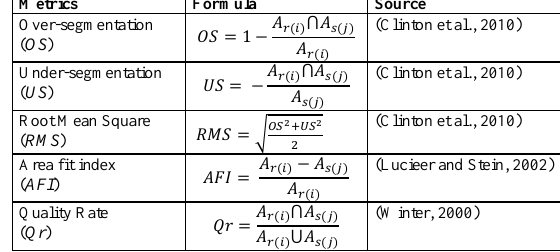
Figure 3. Technical flowchart of the